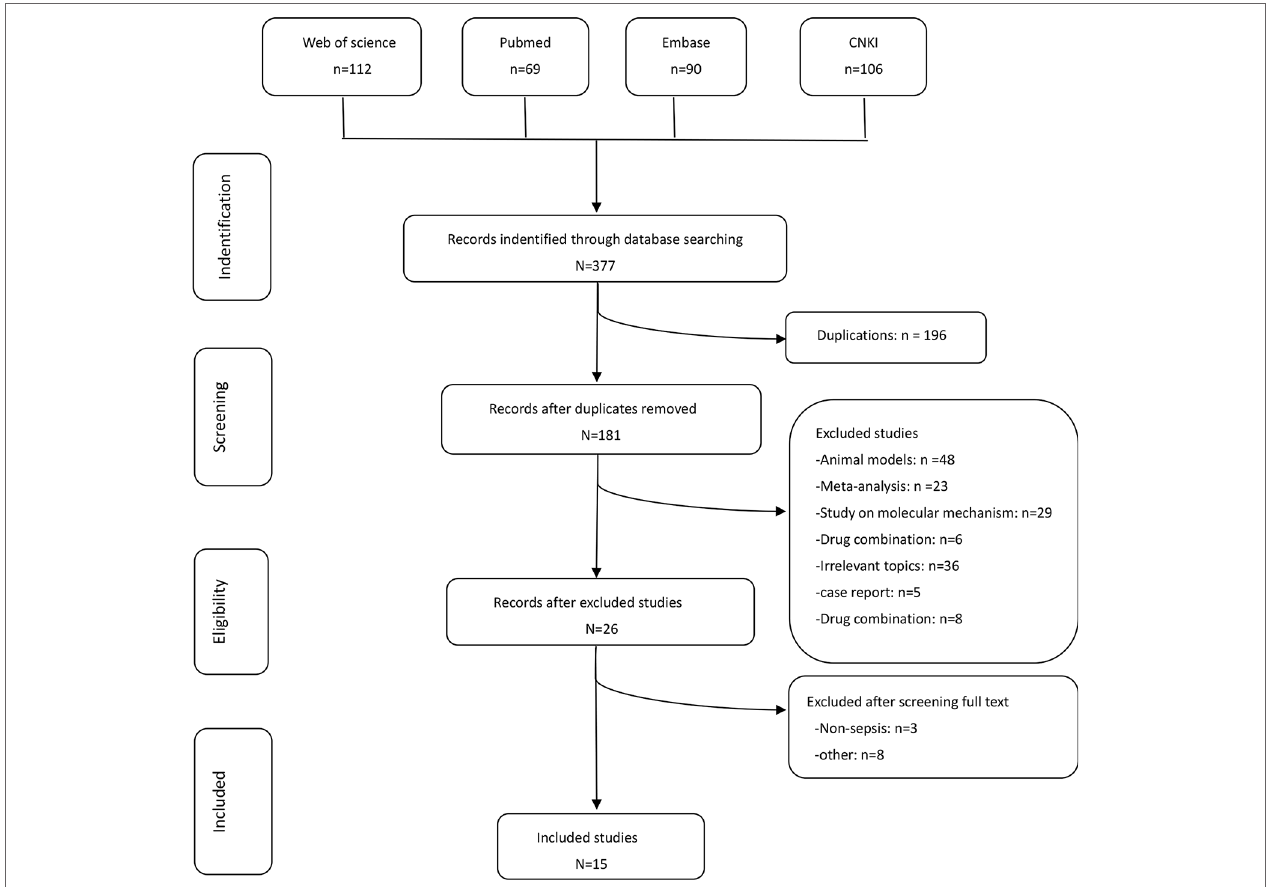
FIGURe 1 | Flow diagram of the study selection process.